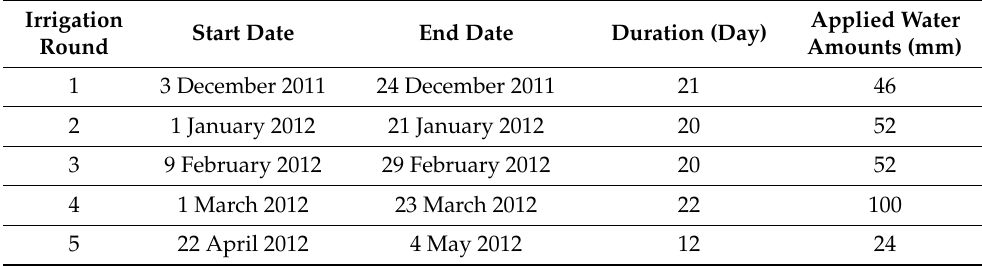
Table 1. Applied irrigation rounds during the 2011–2012 agricultural season in the study